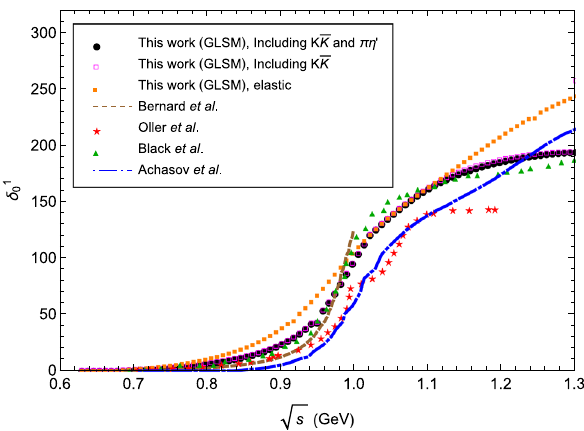
Fig. 19 The prediction of the model for the S-wave πη phase shift using the Flatté parameterization (with the specific inputs A 3 / A 1 = 30 and m [ π( 1300 ) ] = 1 . 38 GeV), is compared with predictions of [138, 147,150,155]. Below the K ¯ K threshold, the Flatté parameterization moves the phase shift closer to the predictions of other